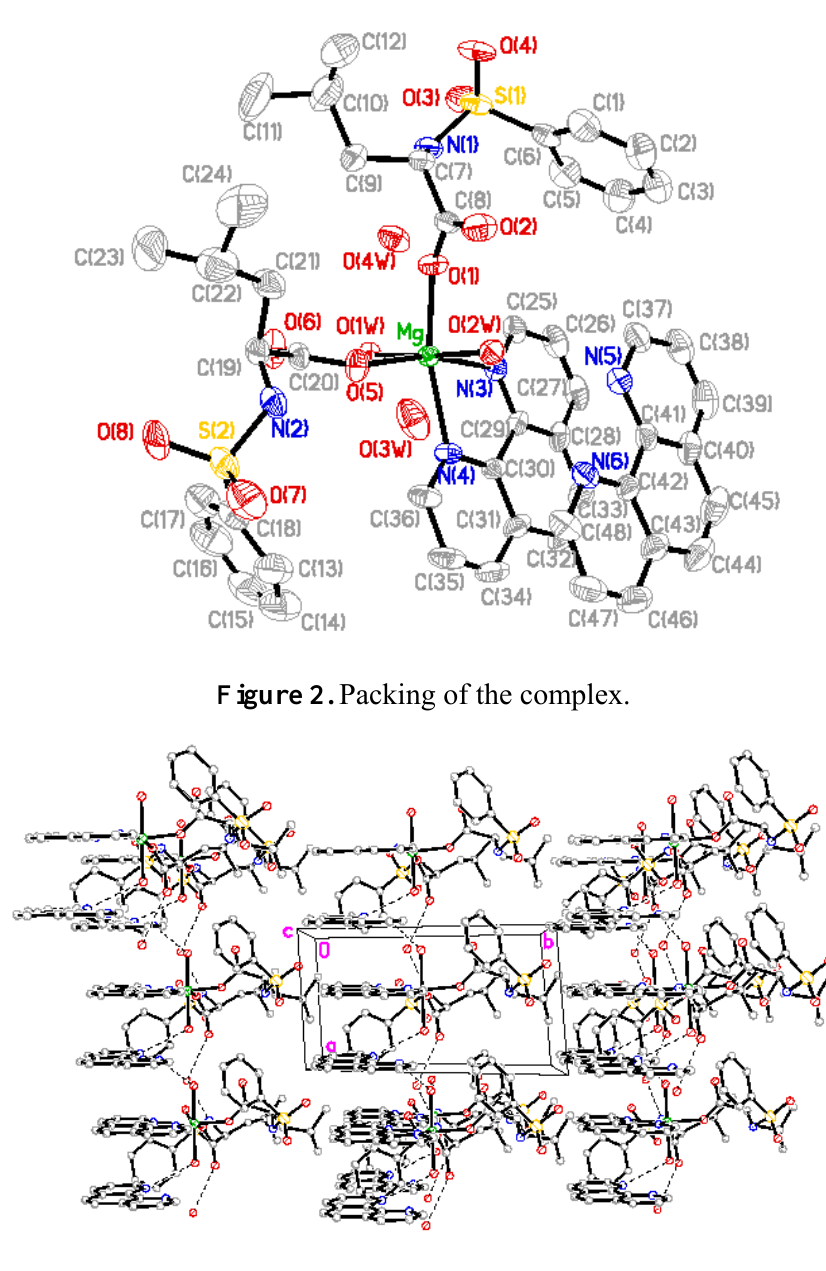
Figure 1. Molecular structure of the complex, where the thermal ellipsoids were drawn at 30% possibility.